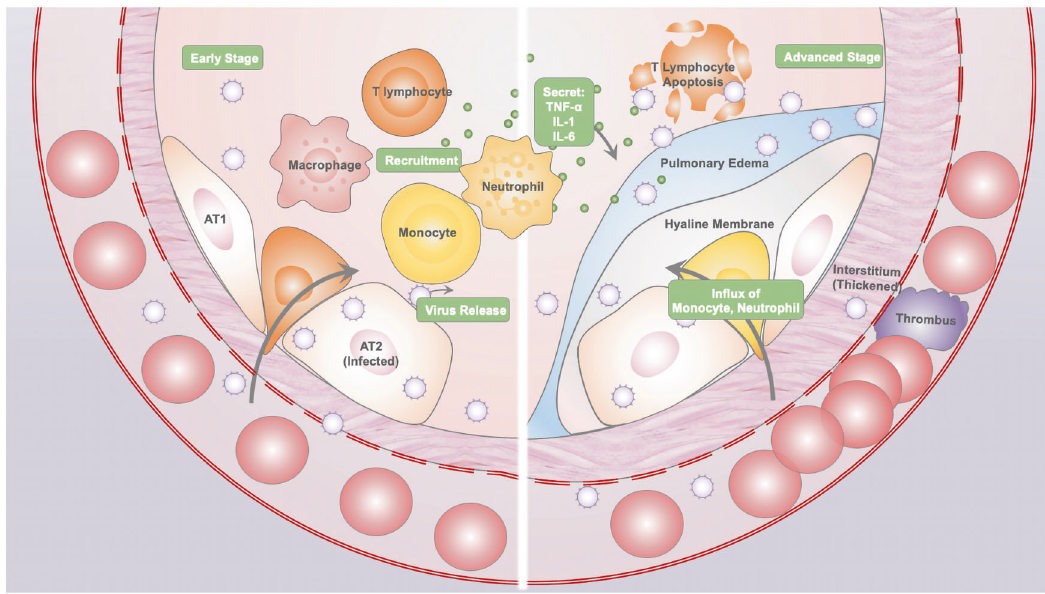
Fig. 1 Immunopathogenesis of coronavirus disease 2019 (COVID-19) in early and advanced